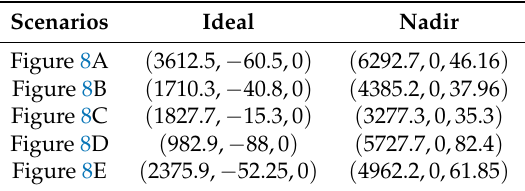
Table 4. Reference points of the five